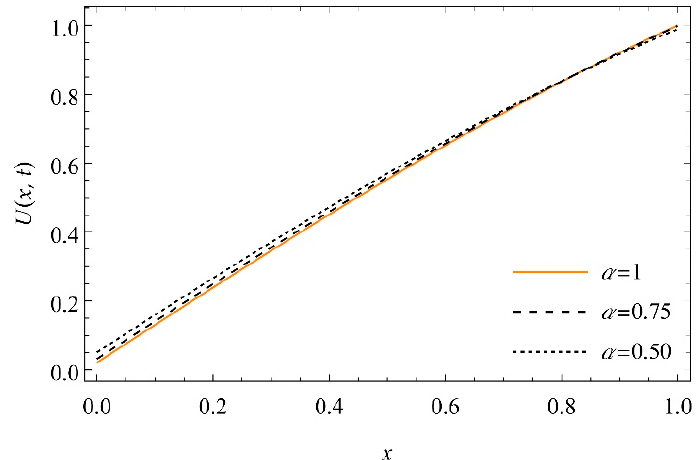
Figure 10. The graph of U ( x , t ) versus depth x at n = 1, t = 0.1, and for α = 1, 0.75, 0.50 for